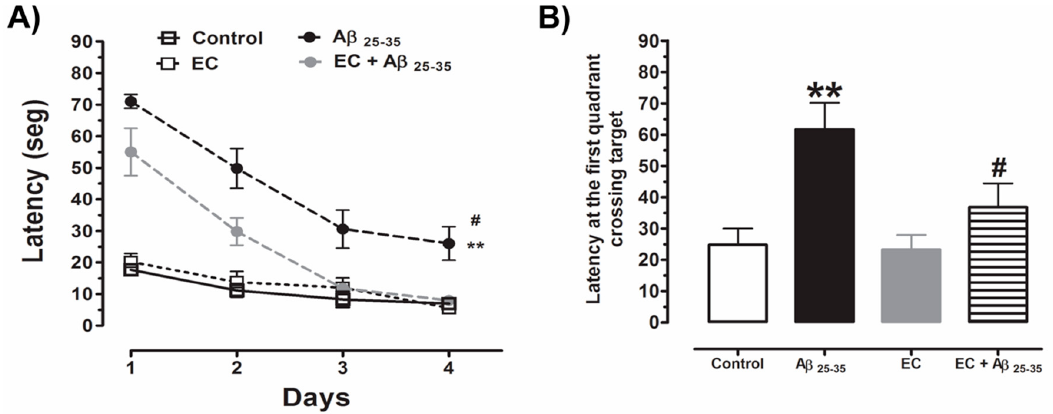
Figure 1. The administration of EC prevents the deterioration in spatial memory that induces the injection of A β 25–35 in the rat Hp. The spatial training test and spatial memory test of rats administered with saline solution, epicatechin, A β 25–35, and epicatechin (EC) + A β 25–35 were performed in the water maze. The parameters to be quantified were the latency time to find the escape platform ( A ) and latency of the first crossing in the objective quadrant ( B ). The values shown represent the standard error (SE) mean one-way ANOVA (** p < 0.01) comparing all groups with respect to the vehicle group. (# p < 0.05) compared the A β 25–35 group versus EC + A β 25–35